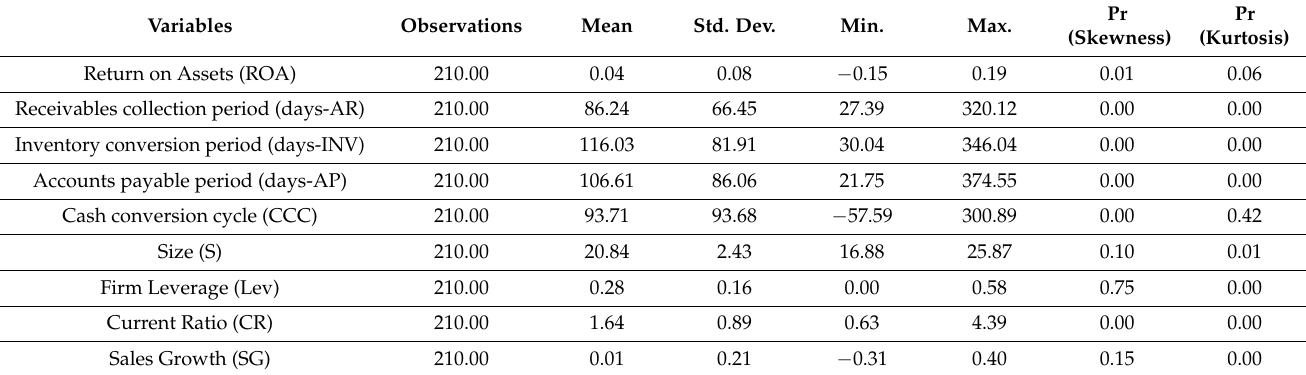
Table 3. Descriptive statistics of the variables (pandemic period, 2020–2021).